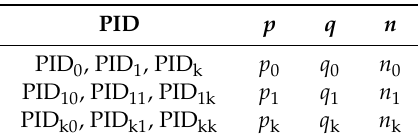
Table 2. PID-data